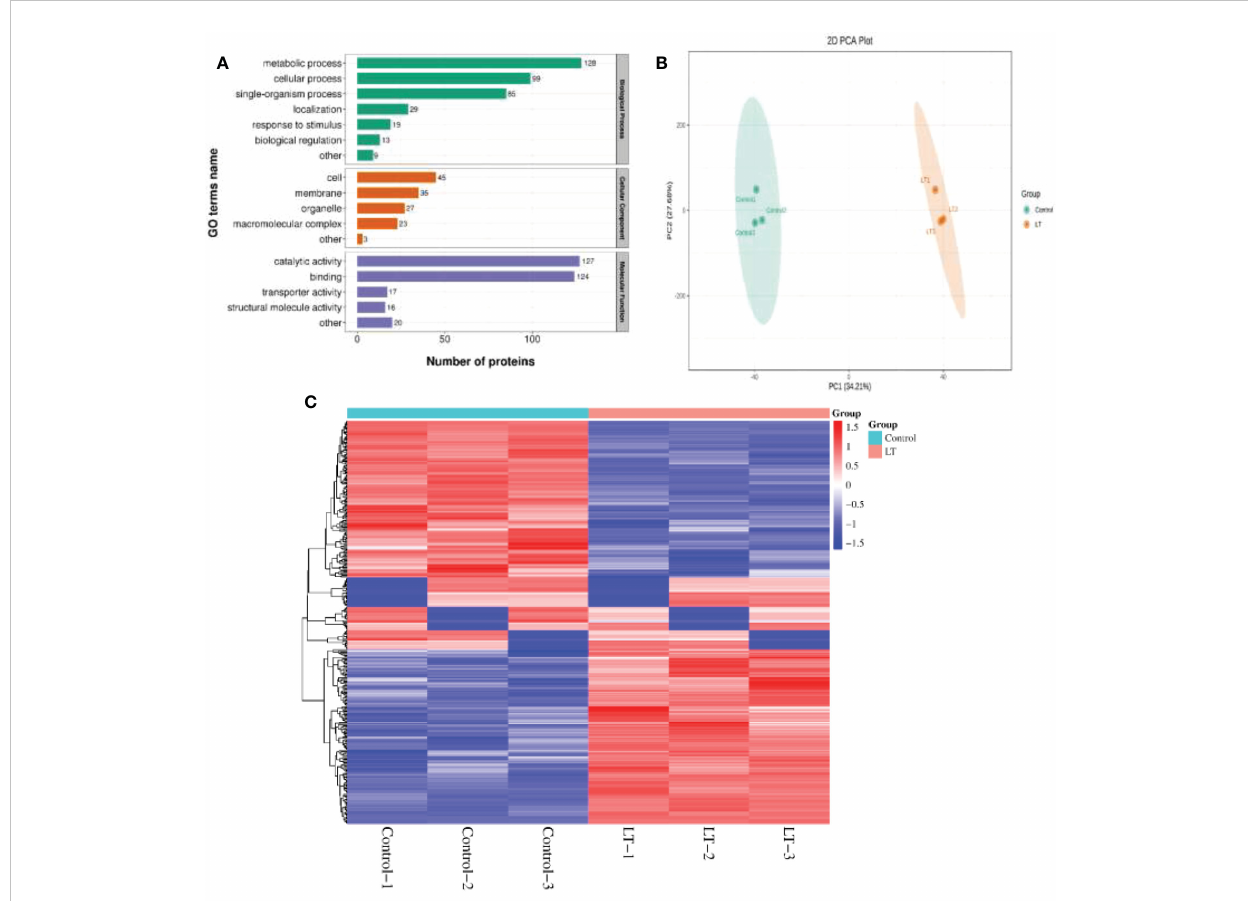
FIGURE 3 Global proteome in response to cold stress of R. chrysanthum . (A) GO enrichment of total DEPs. Protein numbers are displayed above each bar. (B) The divergence of the corresponding proteomes in response to LT and Control is shown by PCA. (C) In comparison to Control samples, DEP abundance under low temperature stress was used to create hierarchically clustered